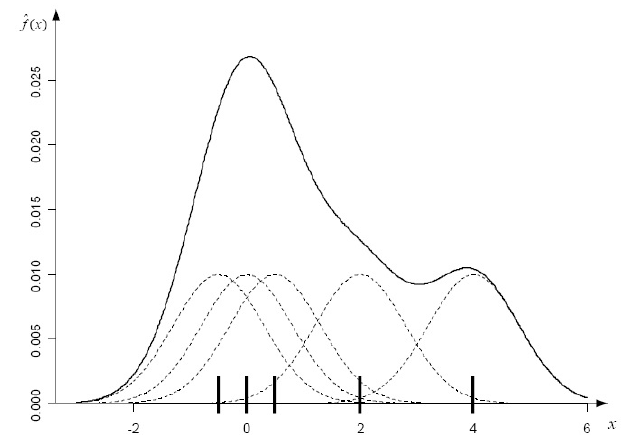
fig. 1. Density function of single-dimensional variable – example Source : own elaboration based on Stępień